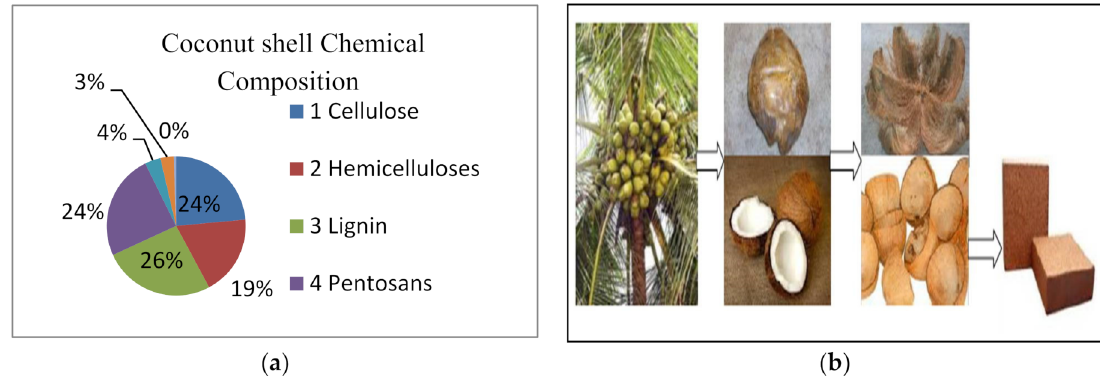
Figure 8. ( a ) Coconut shell chemical composition and ( b ) formation of coconut shell biomass [69].